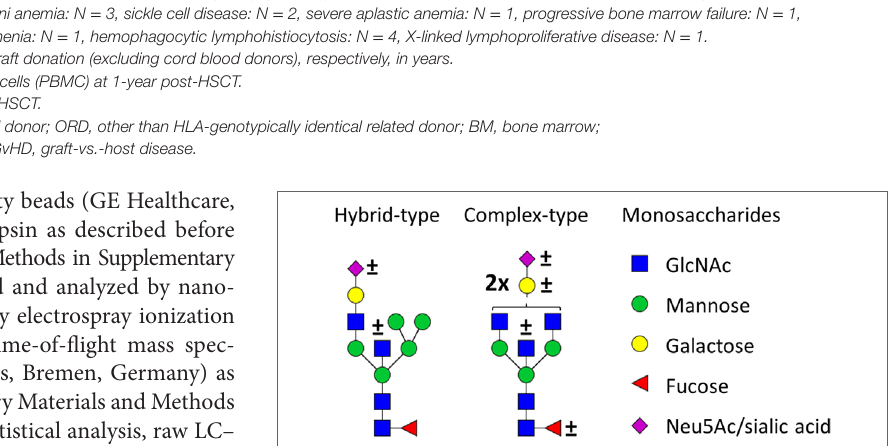
FigUre 1 | Glycan structures found on immunoglobulin G (IgG)-fragment crystallizable (Fc). Both hybrid-type and diantennary complex-type glycan structures were found on the IgG Fc glycopeptides in our study. Hybrid-type glycans varied by the presence of a sialic acid and/or a bisecting N -acetylglucosamine (GlcNAc). Diantennary complex-type glycans were found with zero to two galactoses, zero to two sialic acids, and the presence or absence of a bisecting GlcNAc and/or a core fucose. Monosaccharide linkages were based on literature (6, 13, 20, 21). Green circle: mannose, yellow circle: galactose, blue square: GlcNAc, red triangle: fucose, pink diamond: N -acetylneuraminic acid (Neu5Ac/sialic